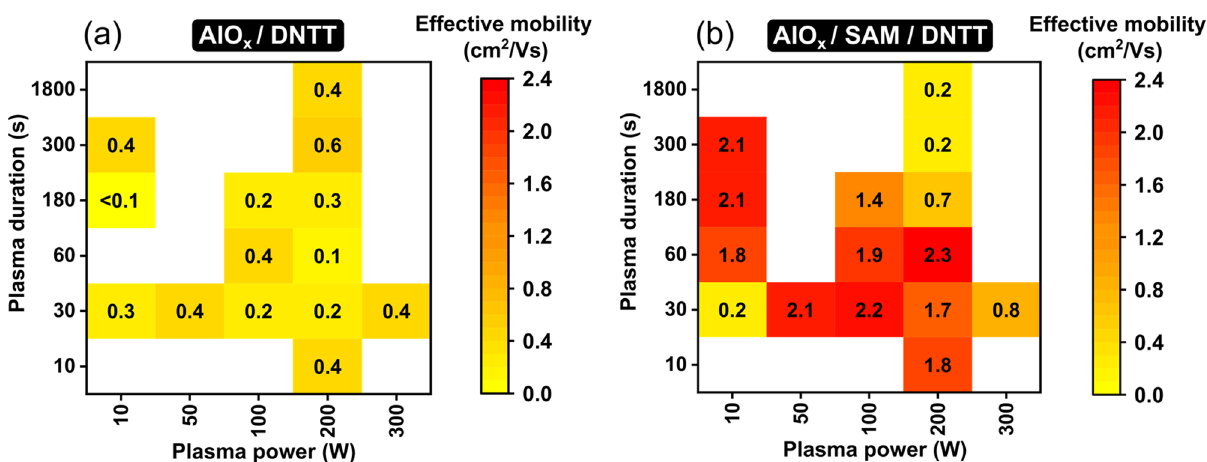
Figure 6. Effective charge-carrier mobilities extracted from the measured transfer characteristics of DNTT TFTs fabricated using either a bare-AlO x gate dielectric ( a ) or a hybrid AlO x /SAM gate dielectric ( b ) as a function of plasma power and plasma